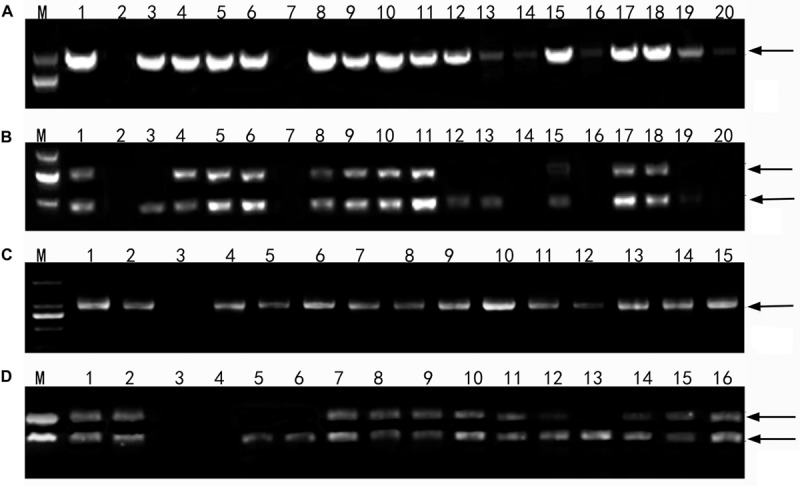
Profiles of DNA amplification of the wheatgrass progeny lines with the genome specific molecular markers. (A) An amplification profile of F1-F4 hybrid plants using the primers P3 and P4 specific for the E genome. Marker: DNA ladder DL2000. Lane 1 Th. intermedium, lane 2 Chinese Spring, lane 3 Ganmai 8, lane 4 Ganmai 9, lane 5 F1 1-11-3, lane 6 F1 1-11-4, lane 7 F1 1-12-1, lane 8 F1 1-12-2, lane 9 F1 1-12-3, lane 10 F1 1-12-4, lane 11 F1 1-12-5, lane 12 F2 2-19-1, lane 13 F2 1-1-4, lane 14 F3 1-18-1, lane 15 F3 1-15-1 lane 16 F3 1-15-2, lane 17 F3 1-15-3, lane 18 F3 1-15-4, lane 19 F4 5-14, and lane 20 F4 4-31. (B) An amplification profile of F1-F4 hybrid plants using primers St542 specific for the St genome. Marker: DNA ladder DL2000. Lane 1 Th. intermedium, lane 2 Chinese Spring, lane 3 Ps. strigosa, lane 4 R. ciliaris, lane 5 F1 1-11-3, lane 6 F1 11-4, lane 7 F1 1-12-1, lane 8 F1 1-12-2, lane 9 F1 1-12-3, lane 10 F1 1-12-4, lane 11 F1 1-12-5, lane 12 F2 2-19-1, lane 13 F2 1-1-4, lane 14 F3 1-18-1, lane 15 F3 1-15-1, lane 16 F3 1-15-2, lane 17 F3 1-15-3, lane 18 F3 1-15-4, lane 19 F4 5-14, and lane 20 F4 4-31. (C) An amplification profile of F5 and F6 perennial hybrid plants using primer P3 and P4. Marker: DNA ladder DL2000. Lane 1 Th. intermedium, lane 2 Th. elongatum, lane 3 Chinese Spring, lane 4 F6 42529356, lane 5 F6 51820443, lane 6 F6 42529344, lane 7 F5 4-0-8, lane 8 F5 4-14-15, lane 9 F5 4-12-13, lane 10 F5 4-25-29, lane 11 F6 412137111, lane 12 F6 41213355, lane 13 F6 42529912, lane 14 F6 414156, lane 15 F6 412133204. (D) An amplification profile of F5 and F6 hybrid plant using primer St542. Marker: DNA ladder DL2000. Lane 1 Th. intermedium, lane 2 P. strigose, lane 3 Th. elongatum, lane 4 Chinese Spring, lane 5 F6 42529356, lane 6 F6 51820443, lane 7 F6 42529344, lane 8 F5 4-0-8, lane 9 F5 4-14-15, lane 10 F5 4-12-13, lane 11 F5 4-25-29, lane 12 F6 412137111, lane 13 F6 41213355, lane 14 F6 42529912, lane 15 F6 414156, and lane F6 412133204. Arrows indicate the target amplification products.